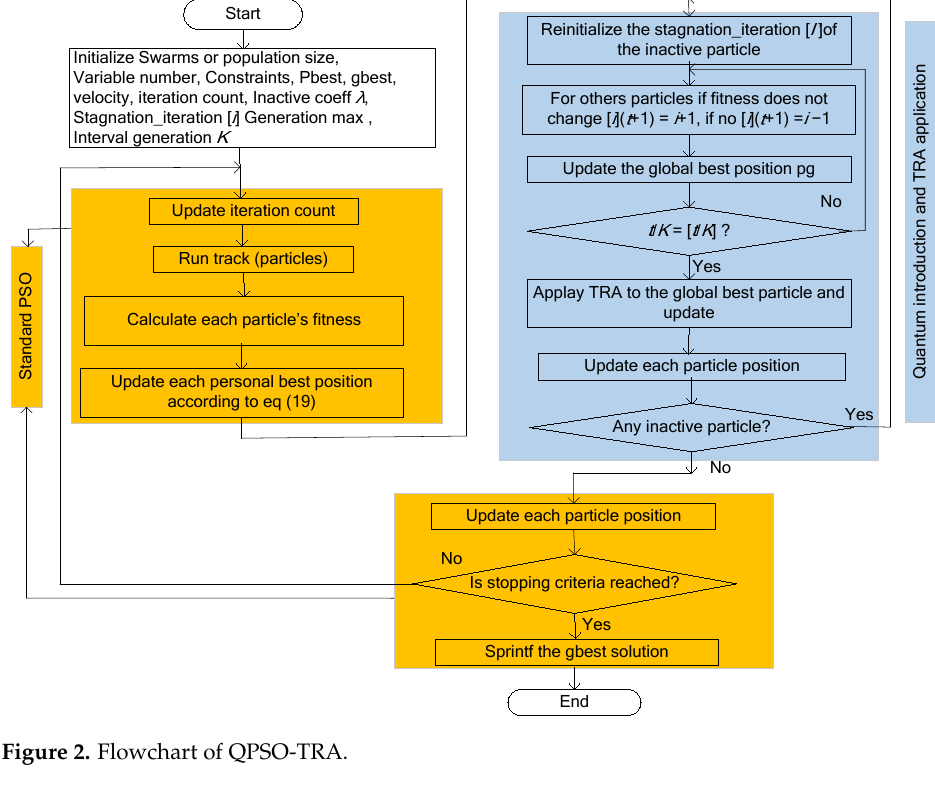
Figure 2. Flowchart of QPSO-TRA.